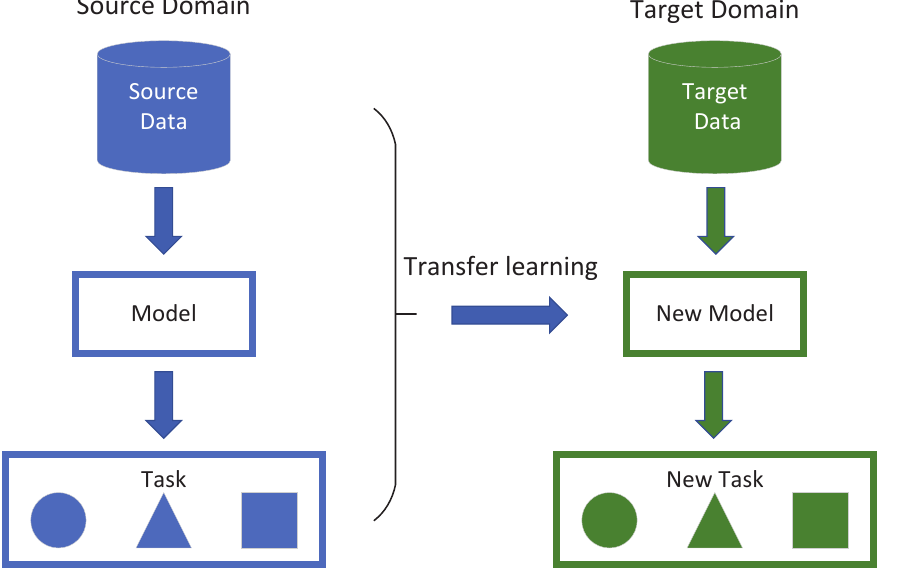
Figure 1. An example of transfer learning